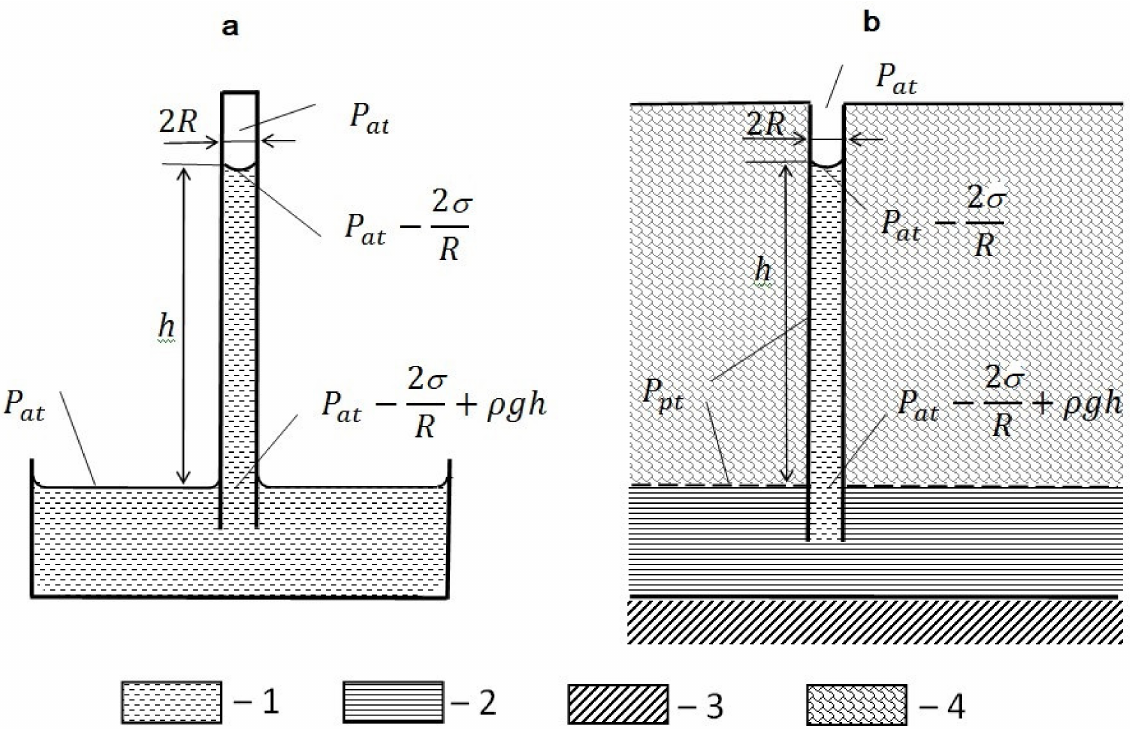
Figure 12. The simplest schematics of a single capillary: ( a ) rigid capillary (as considered in [31]); ( b ) elastic capillary within a peat soil profile: 1–water, 2—suprapermafrost aquifer, 3—impervious permafrost; 4—peat or peaty